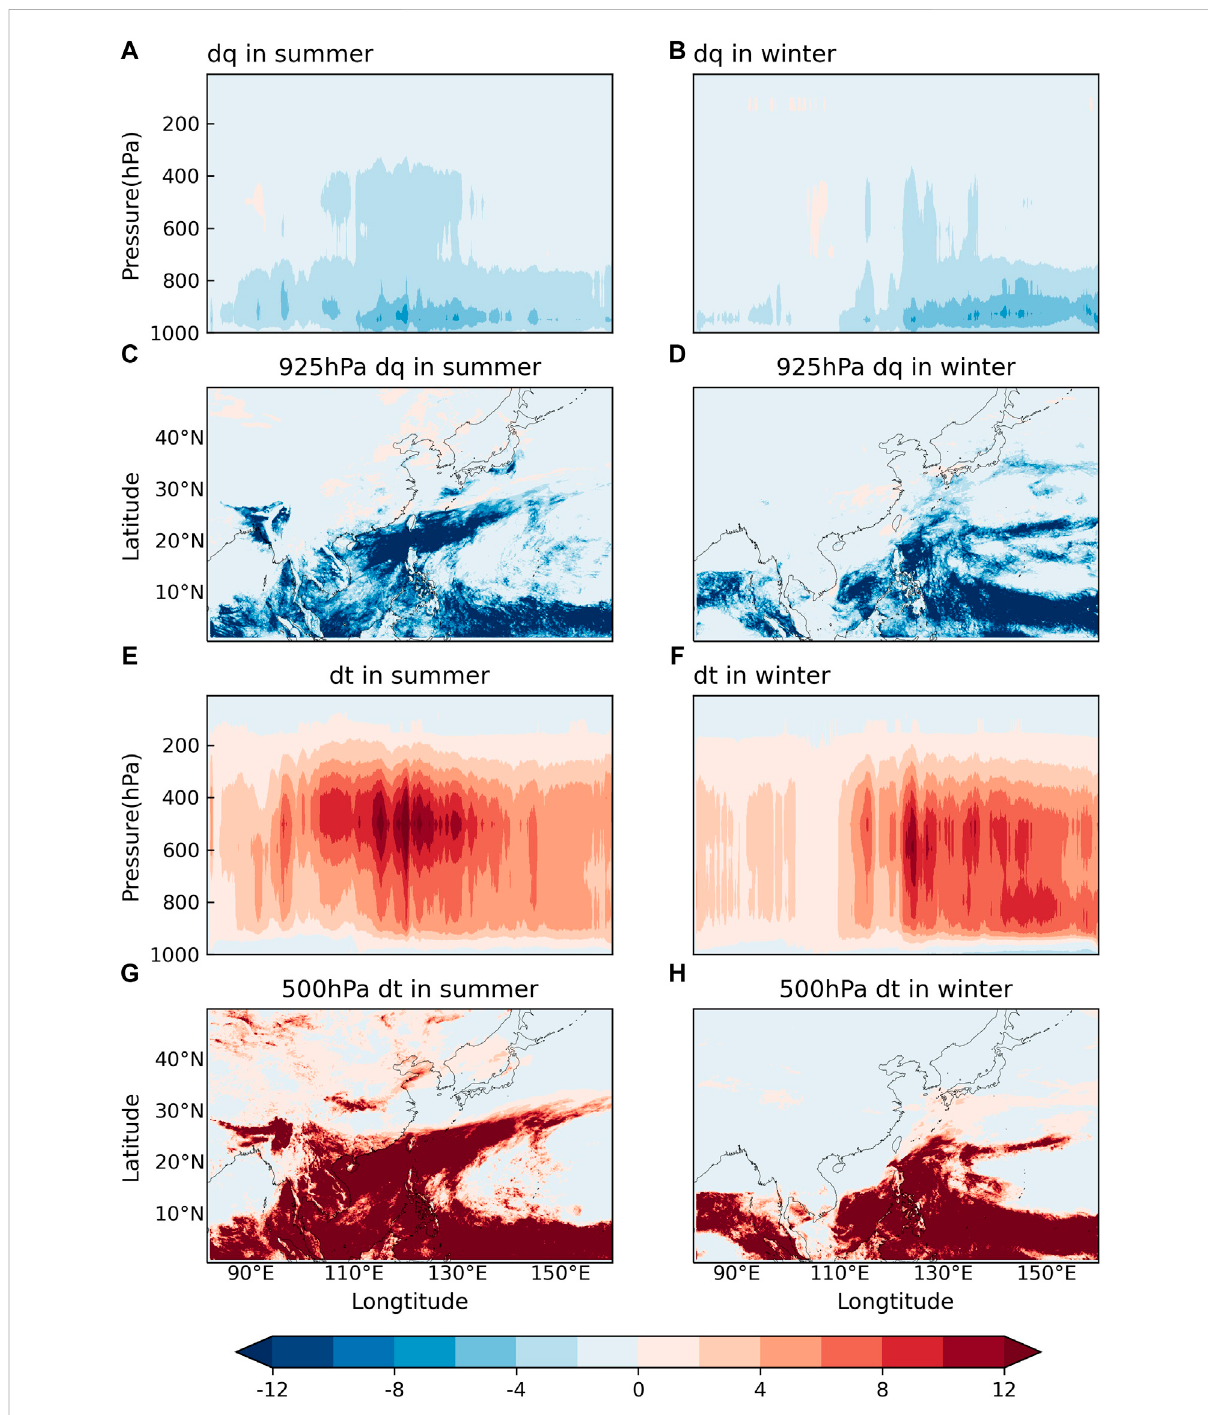
FIGURE 6 Vapour and temperature tendencies of the cumulus convection process. (A – D) Vapour tendency (10 – 3 g/kg). (E – H) Temperature tendency ( ° C). (A,E) Latitudinal average cross-section in the summer. (B,F) Latitudinal average cross-section in the winter. (C) 925 hPa in the summer. (D) 925 hPa in the winter. (G) 500 hPa in the summer. (H) 500 hPa in the